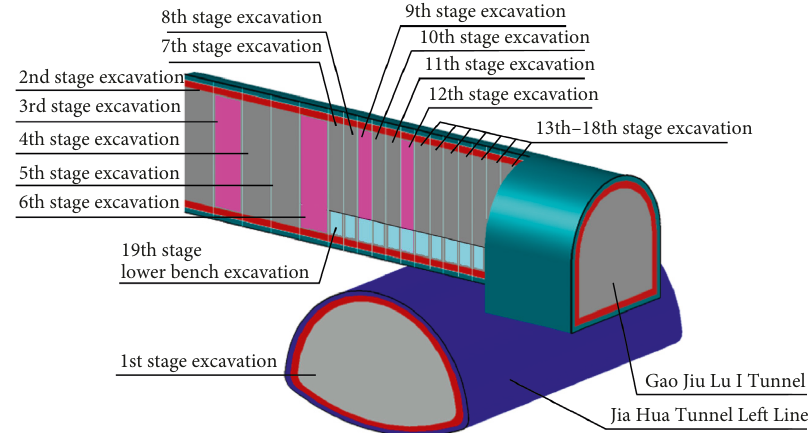
Figure 11: Model simulation excavation process flow chart.